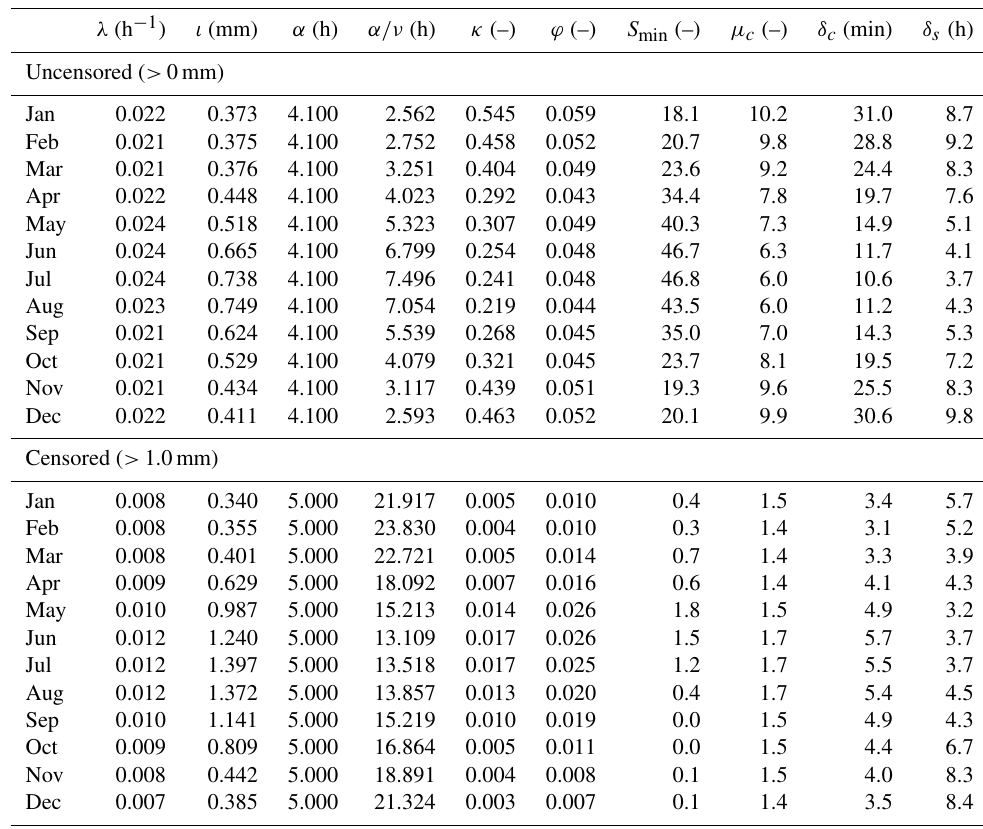
Table B3. BL1M model parameters for the Bochum 15min